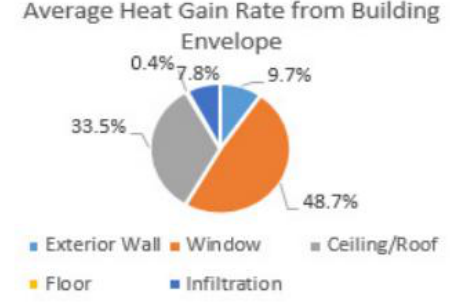
Figure 6. Average heat loss and gain